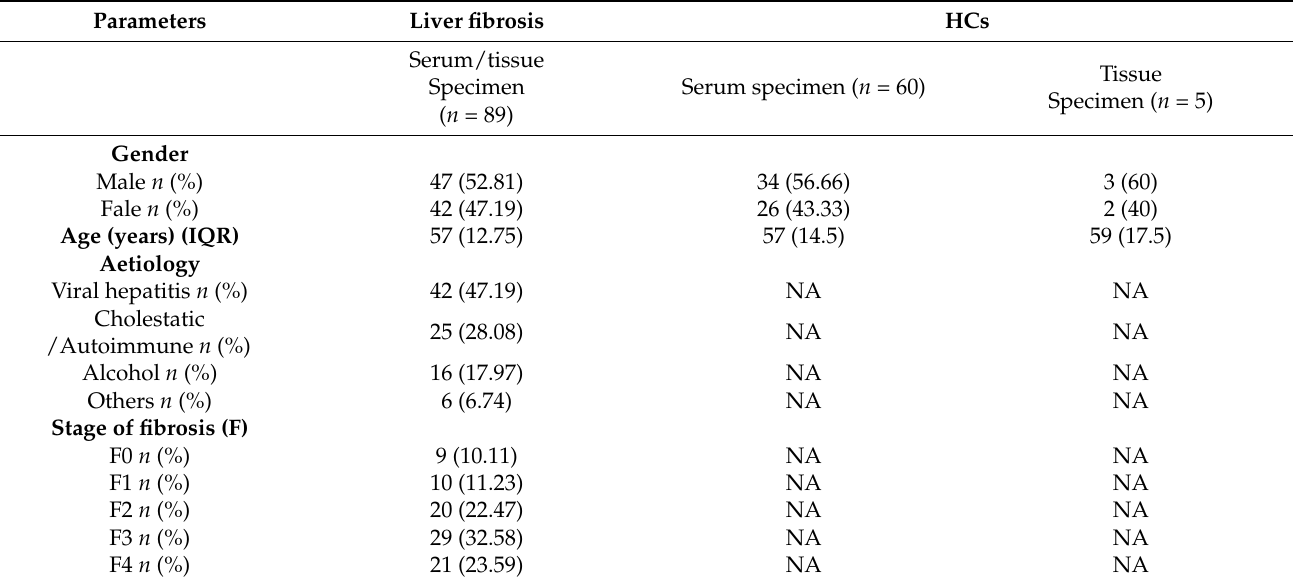
Table 1. The characteristics of enrolled